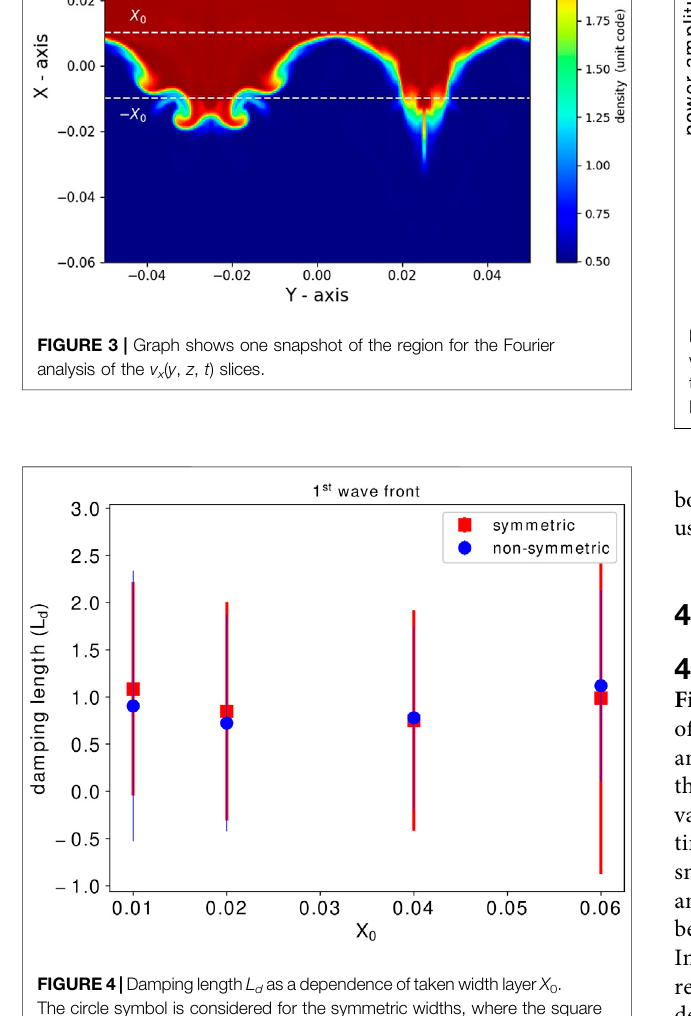
FIGURE4| Dampinglength L d asadependence oftakenwidthlayer X 0 . The circle symbol is considered for the symmetric widths, where the square symbol represents the non-symmetric strips.